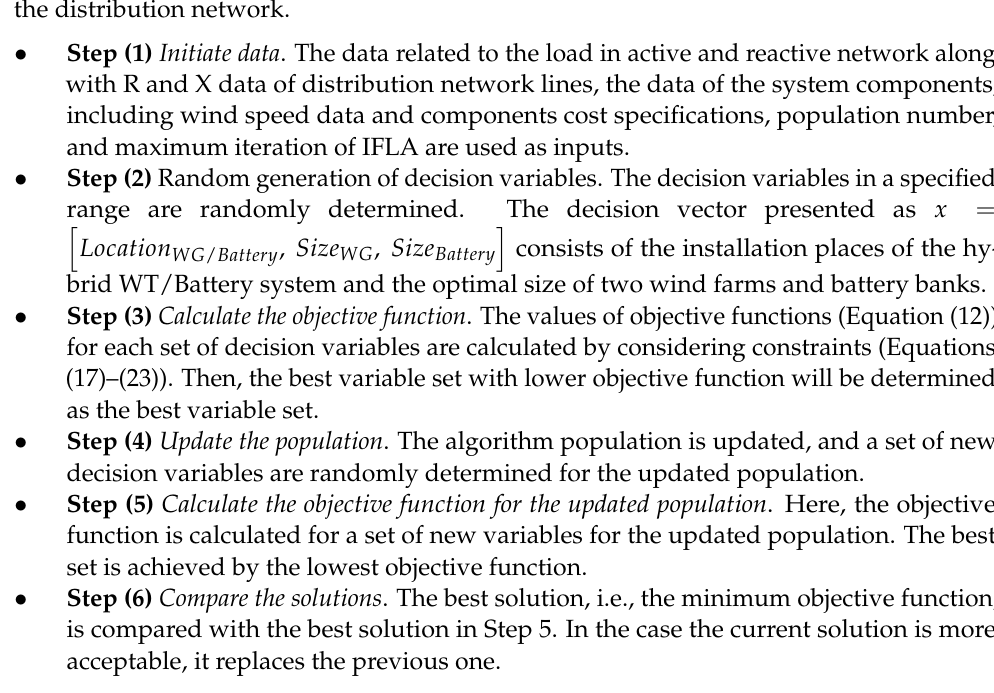
Table 3. The results of Wilcoxon’s test. Corresponding Algorithm PSO